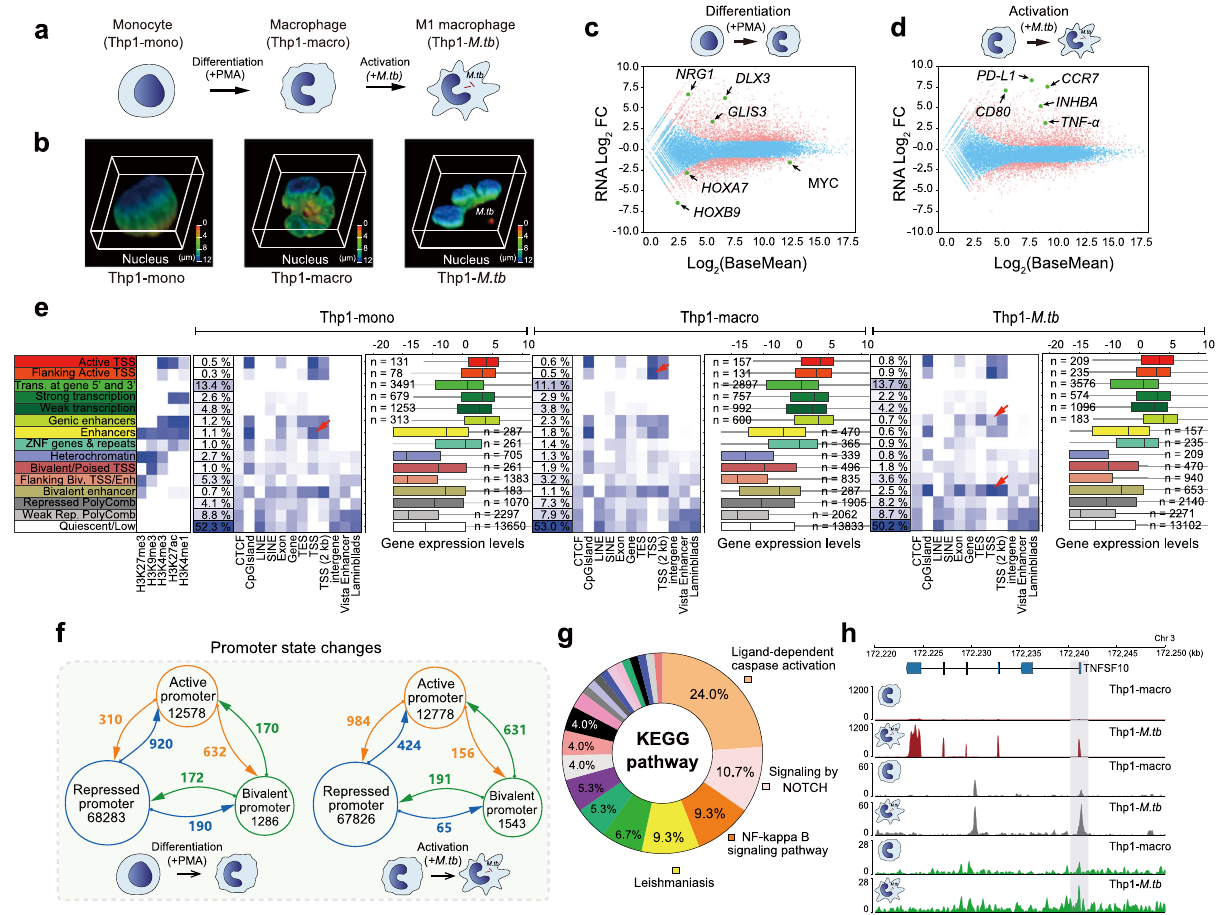
Fig. 1 | Morphological and chromatin state dynamics of THP-1 cells during differentiation and M.tb infection. a Cartoon of Thp1-mono, Thp1-macro, and Thp1- M.tb . b Reconstructionofthethree-dimensionalstructureofthenucleus.The nuclei were stained with Hochest and reconstructed. The different colors indicate different depths. c MA plot for gene differential expression analysis during Thp-1 cell differentiation. X -axis represents the mean of normalized counts, and Y -axis represents the log 2 fold changes of gene expression level. Important transcription factors related to cell proliferation and differentiation are highlighted. d MA plot forgenedifferentialexpressionanalysisduring M.tb infection. X -axisrepresentsthe mean of normalized counts, and Y -axis represents the log 2 fold changes of gene expression level. Marker genes and important transcription factors for macro- phages and M1 macrophages are highlighted. e Chromatin state de fi nitions